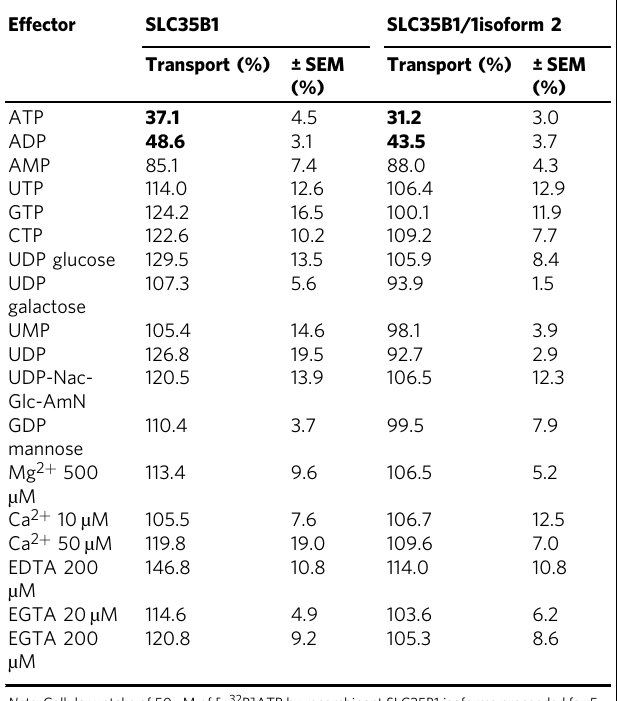
Table 1 Impact of potential substrates and effectors on ATP transport by SLC35B1 Effector